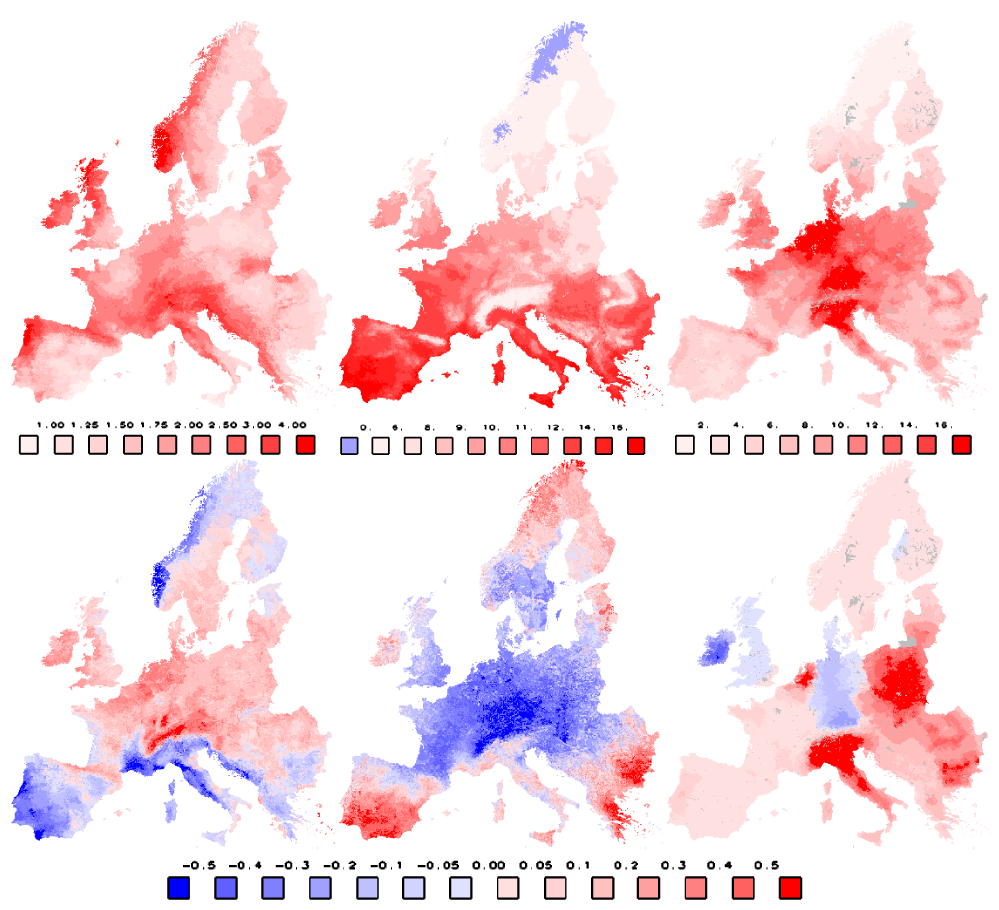
Fig. 5. The top row shows decadal average environmental drivers 2011–2020. The bottom row are differences in decadal average environ- mental drivers 2021–2030 minus 2011–2020. The left column is precipitation (mmday − 1 ) , the middle is temperature ( ◦ C) and the right is nitrogen deposition (kgNha − 1 yr − 1